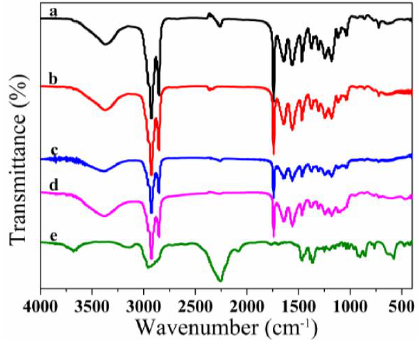
Figure 5. FT-IR spectra of various MicroPCMs and shell-forming monomer: ( a ) polyurea microcapsules; ( b ) polyurethane microcapsules; ( c ) polyurea – SiO 2 microcapsules; ( d ) polyurethane – SiO 2 microcapsules; ( e ) IPDI monomer.